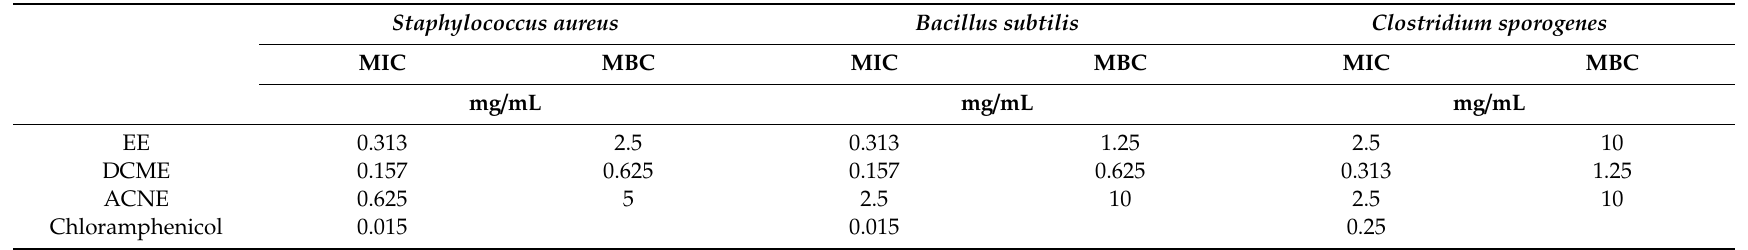
Table 4. Antibacterial activity of H. plicatum ethanol (EE), dichloromethane (DCME), and acetonitrile oil (ACNE) extract against Gram-positive bacteria.